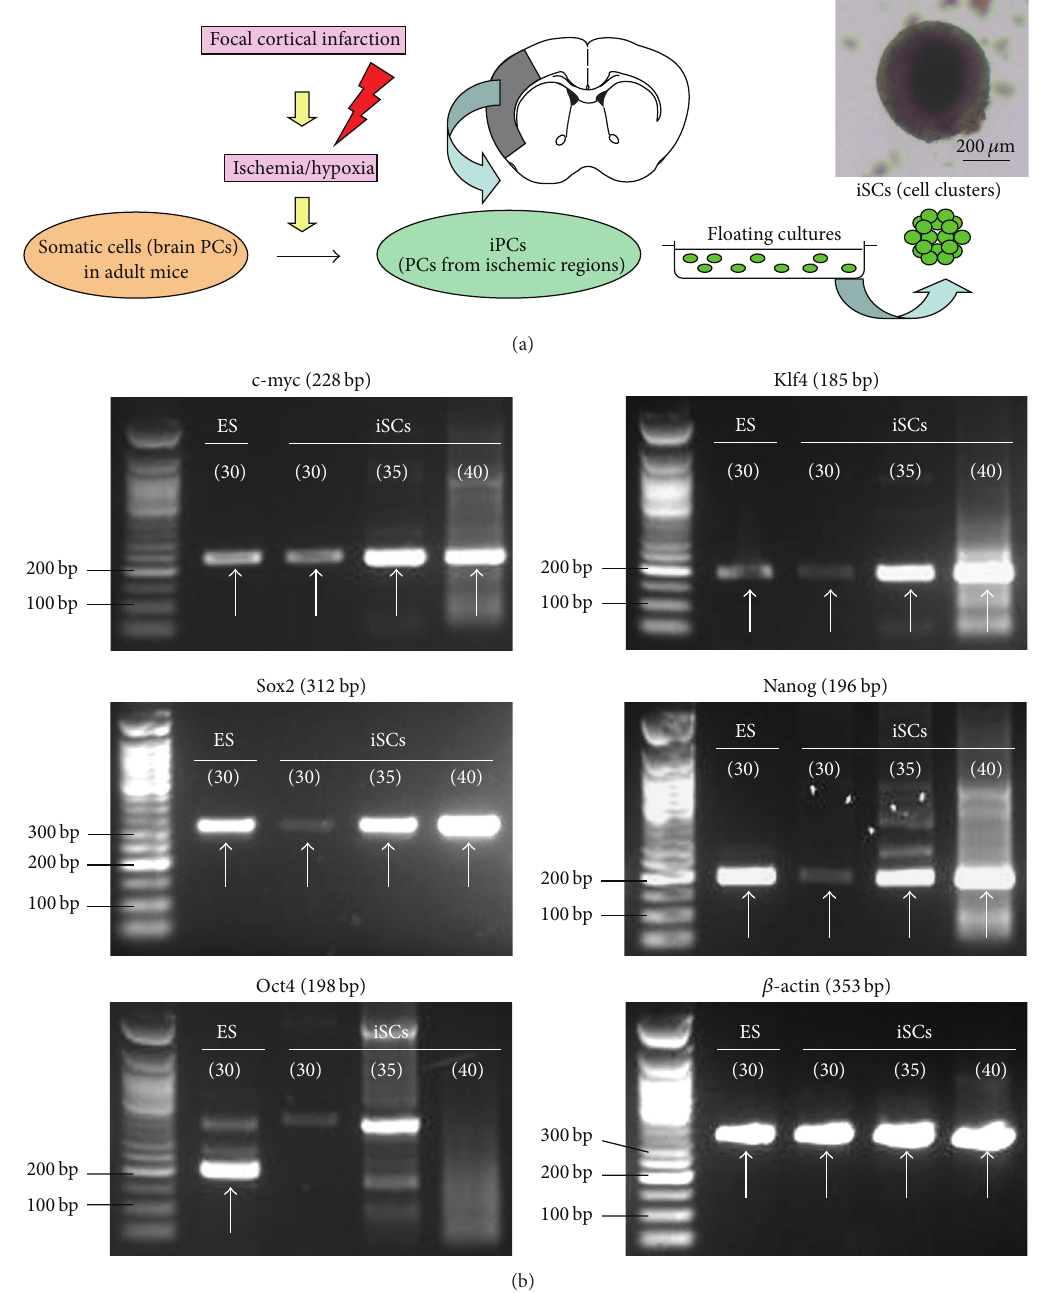
Figure 1: iSCs were isolated from ischemic areas and formed cells clusters (a). iSCs as well as control ES cells expressed c-myc, Klf4, Sox2, and Nanog. However, Oct4 was not observed even after > 35 cycles of PCR amplification. The cycle number of PCR amplification is shown in the circles